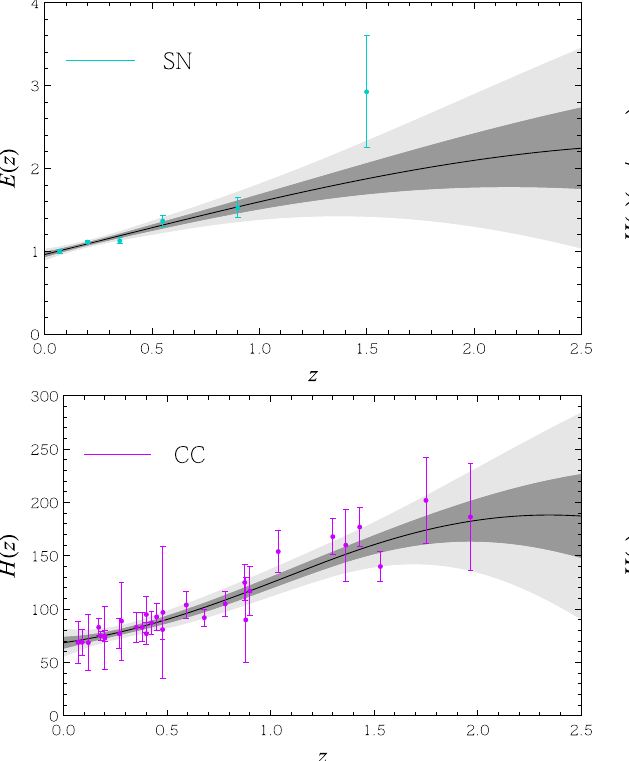
(bottom-right). Data with errorbars in all the panels are the observa- tional data as mentioned in the legend of each